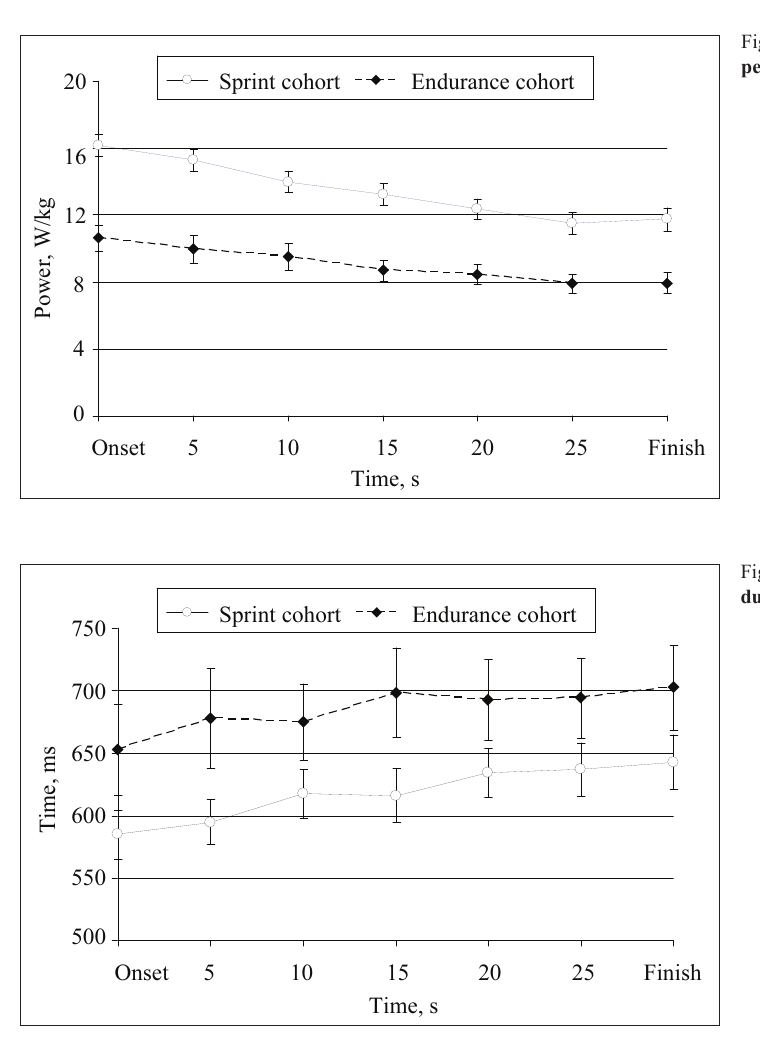
Figure 3. Duration of take-off while performing 30-s duration jump test